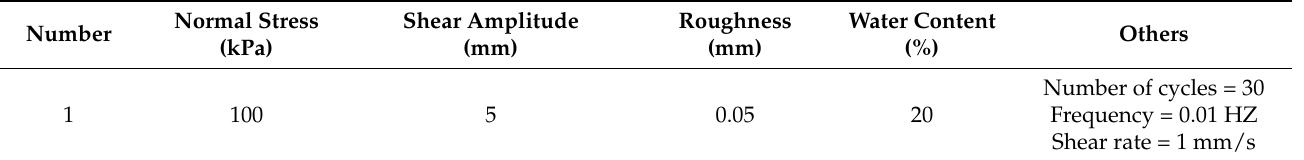
Table 1. Testing scheme.